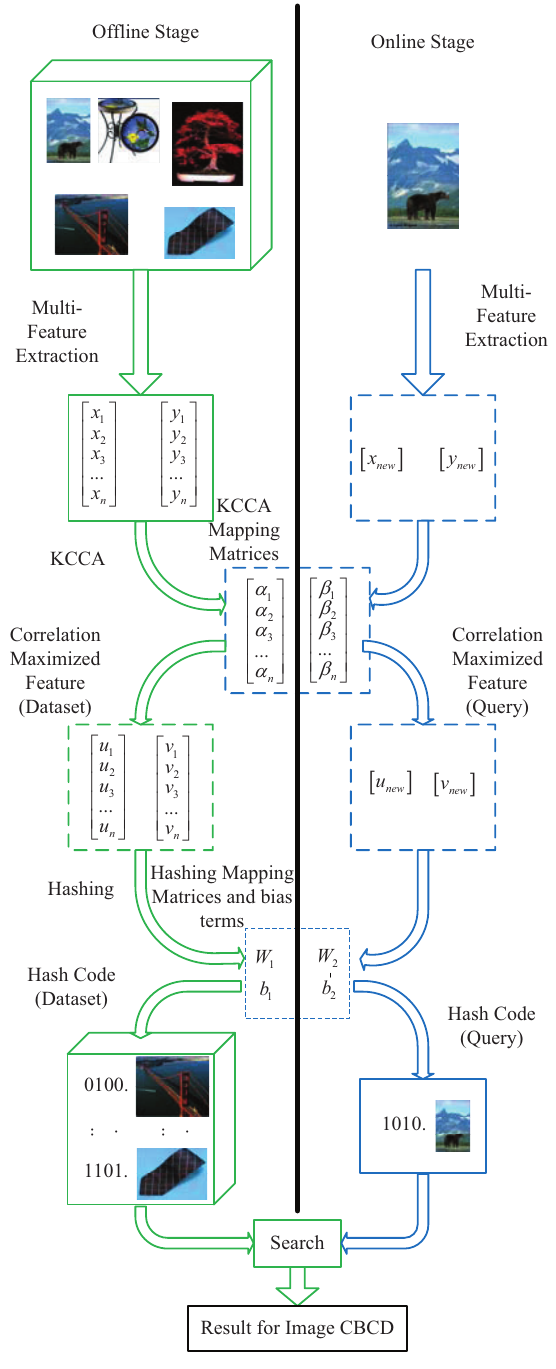
Fig. 1. proposed Framework for Image Copy